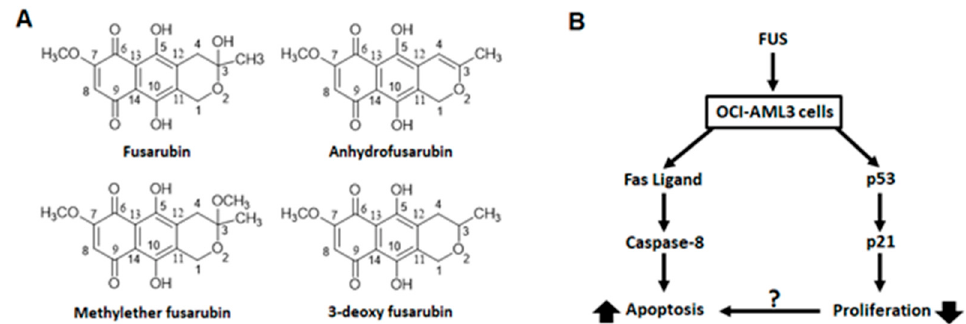
Figure 4. Fusarubin (FUS) and FUS analogues with proposed mechanism of action. ( A ) Structures of FUS derivatives and ( B ) Proposed mechanism of action of FUS on OCI-AML3 cells.